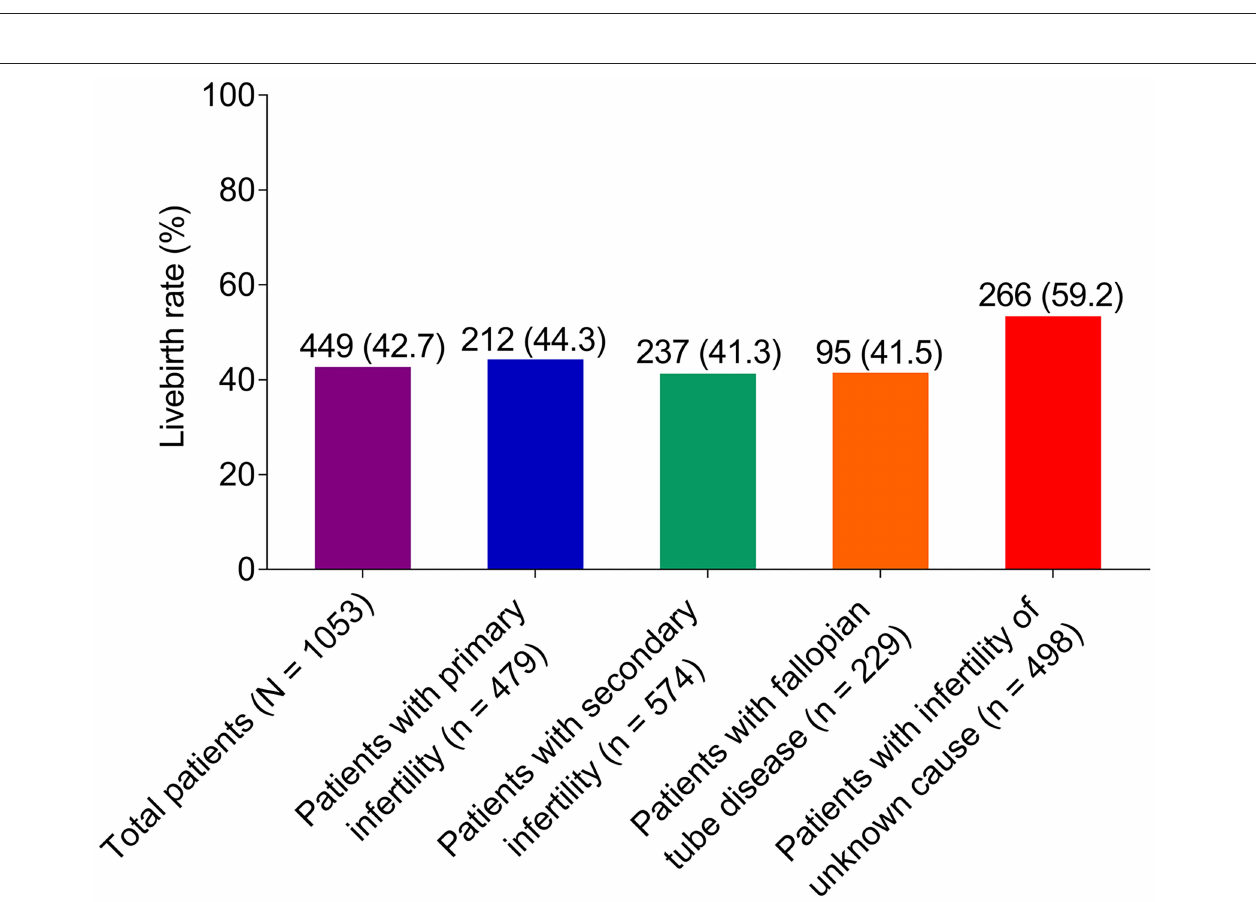
FIGURE 2 | Effect of ethiodized poppy seed oil for HSG on live birth rate in infertile patients. HSG, hysterosalpingography.